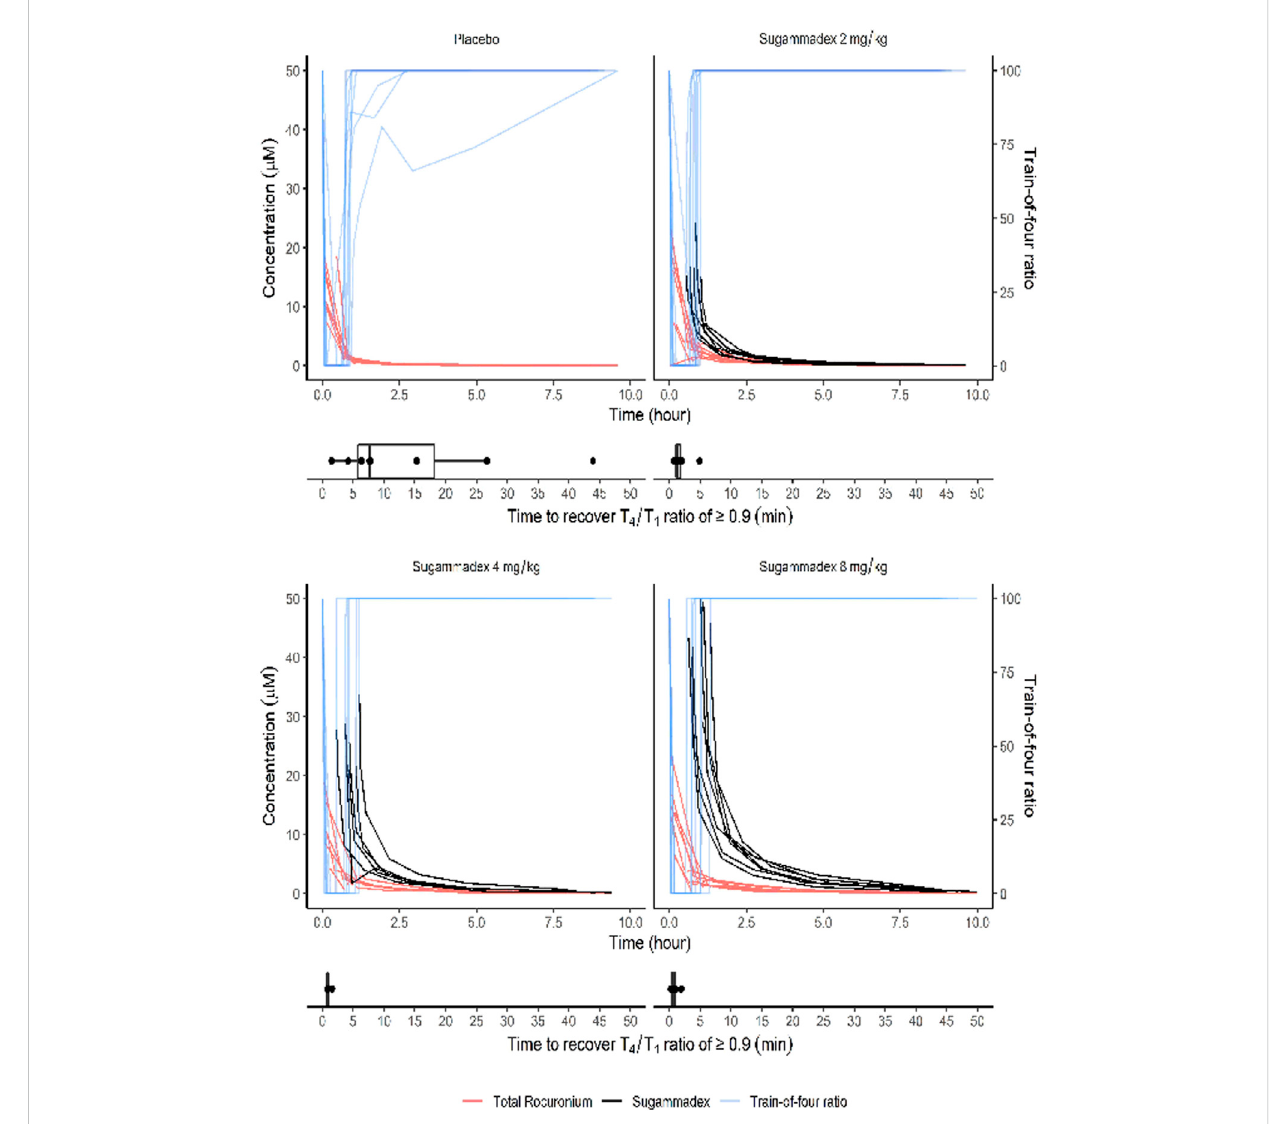
FIGURE 3 The T 4 /T 1 ratio in response to train-of-four stimulation shown together with plasma molar concentrations of sugammadex and rocuronium. The box plots show the time from study drug administration to recovery of a T 4 /T 1 ratio ≥ 0.9 in response to train-of-four stimulation. Molar concentrations were calculated based on the molecular weights of rocuronium (529.8 g/mol) and sugammadex (2,002